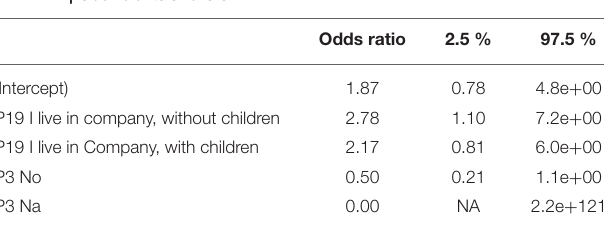
TABLE 4 | Coefficients and CIs.